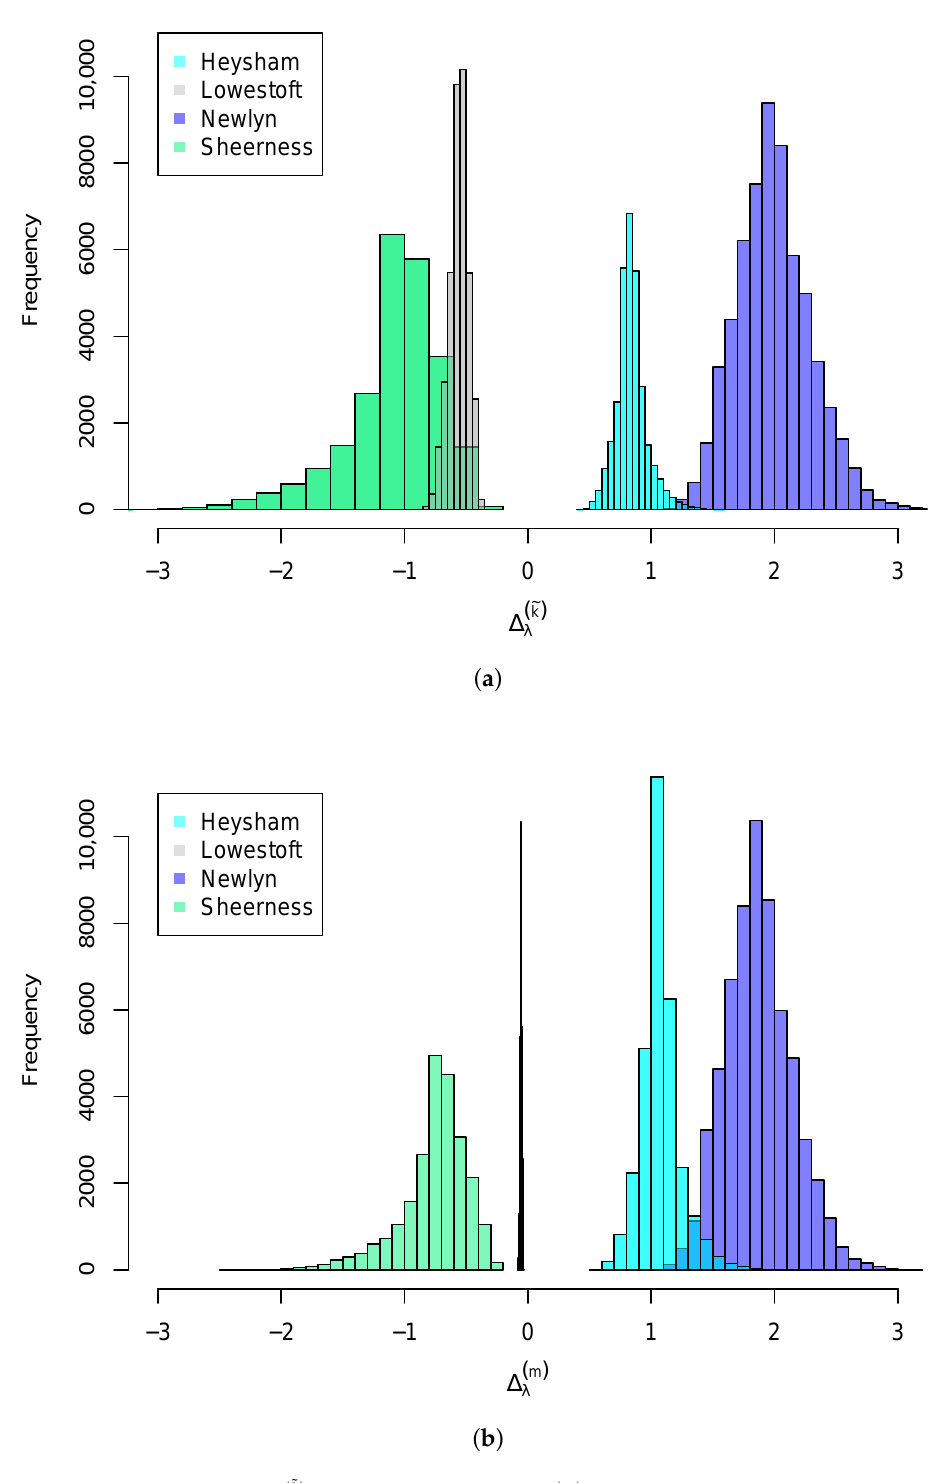
( ˜ k ) over 100 years and ( b ) ∆ λ